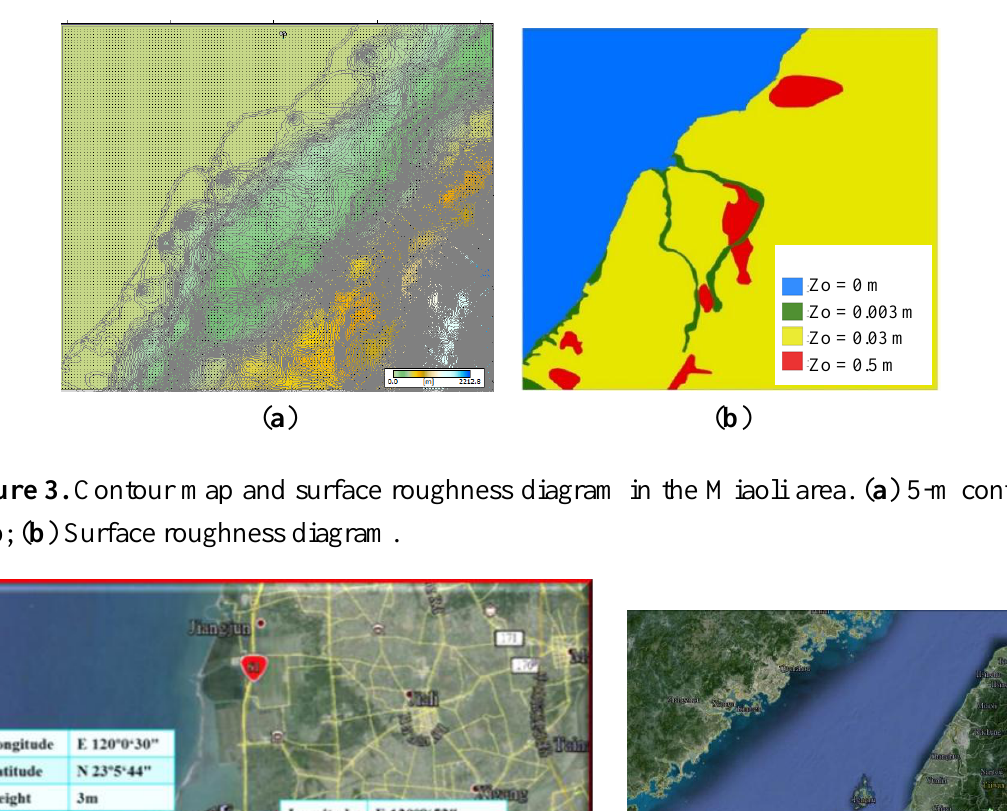
Figure 2. Locations of the Waipu tidal station and Lidar system in the Miaoli area.